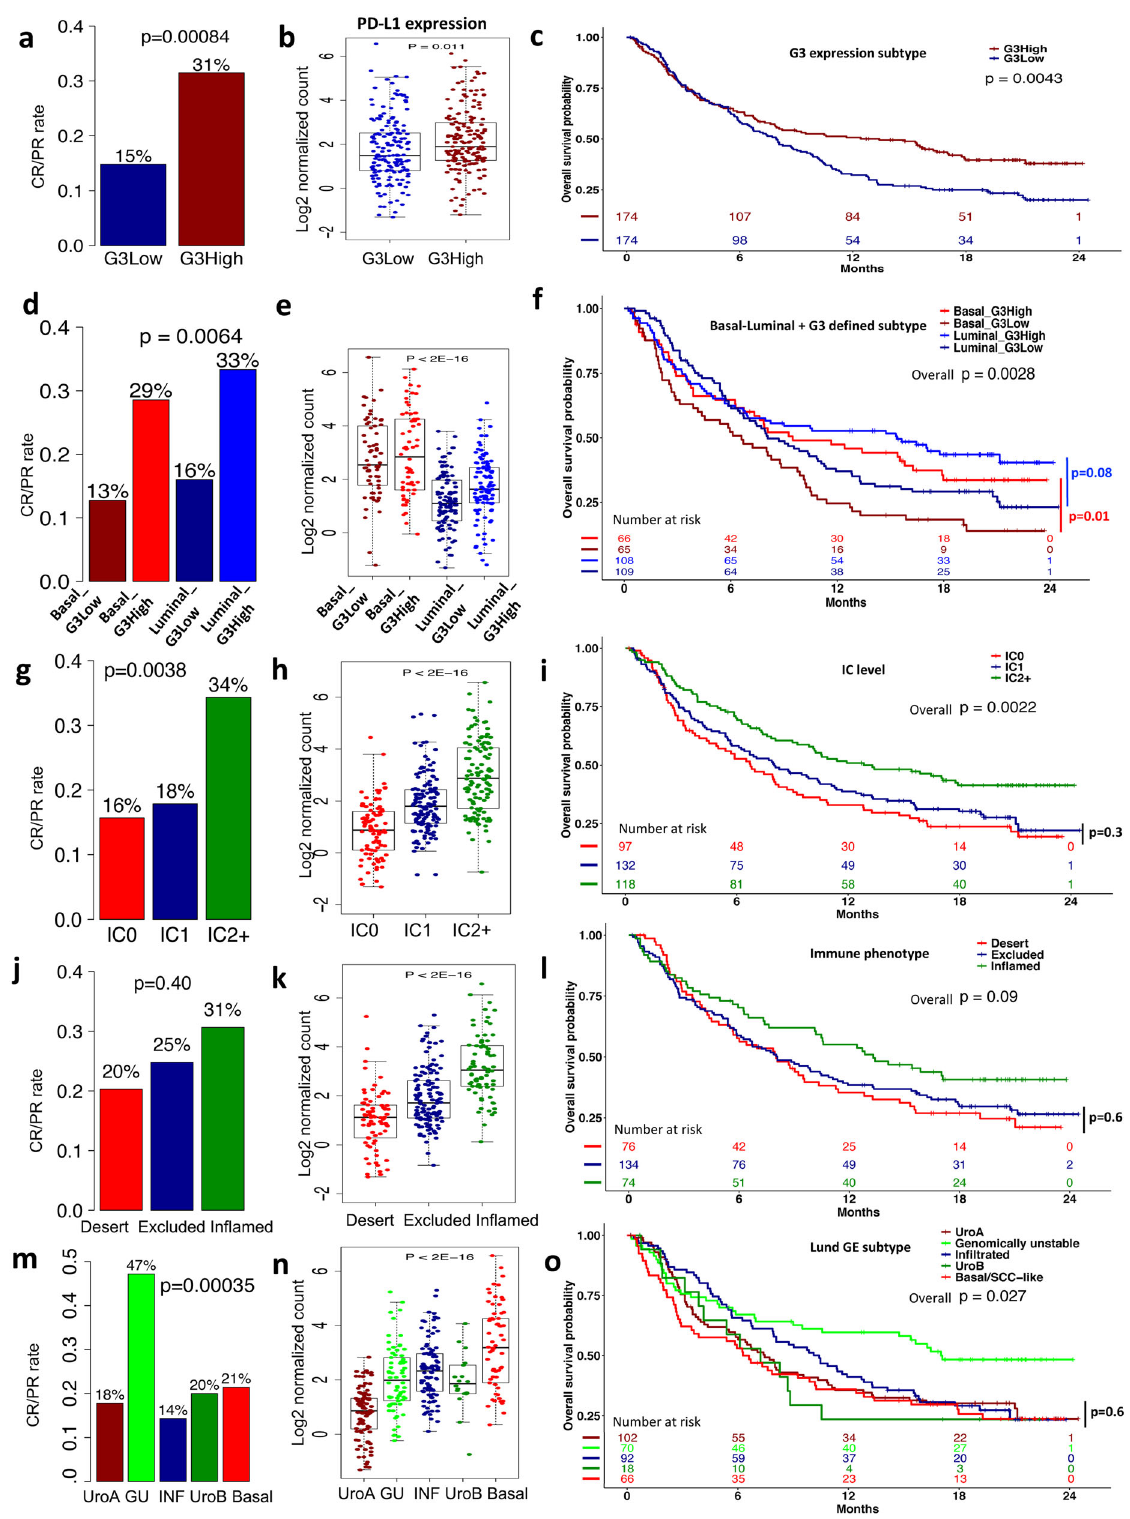
Fig. 4 Subtype-speci fi c response (CR/PR) rates of PD-L1 blockade therapy, PD-L1 expression levels, and survival in the IMvigor210 cohort. a Response rates, b PD-L1 expression levels, and c KM survival curves of the G3High and G3Low groups. d Response rates, e PD-L1 expression levels, and f KM survival curves of the G3High and G3Low groups in the basal and luminal sub-cohorts. g Response rates, h PD-L1 expression levels, and i KM survival curves of the immune cell (IC) subgroups. j Response rates, k PD-L1 expression levels, and l KM survival curves of the tumor-immune phenotypes. m Response rates, n PD-L1 expression levels, and o KM survival curves of the Lund subtypes. Fisher exact test was used to compare the CR/PR frequencies; t-test or ANOVA was used to compare PD-L1 expression between the subtypes. Log-rank test was used to compare subtype-speci fi c survival curves.